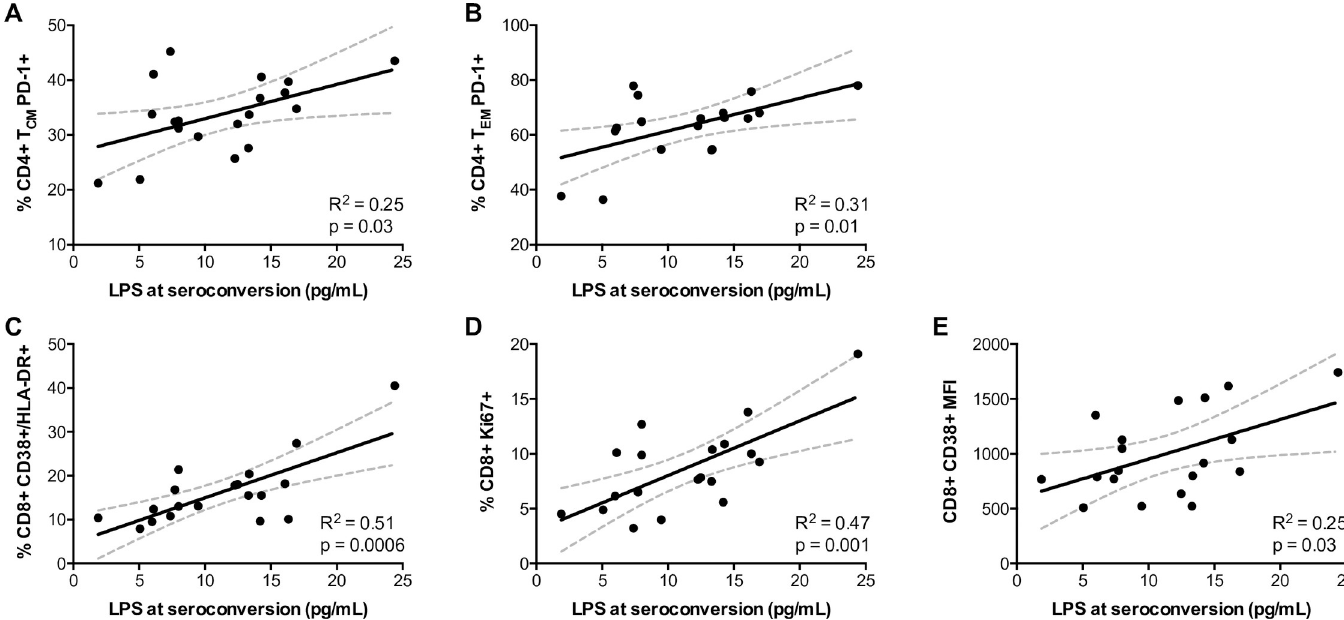
Fig 5. The levels of circulating LPS at seroconversion predict levels of cellular immune activation in the T cell compartment at 3 months post infection. Cryopreserved PBMCs isolated 3 months (mean of 97 days) post infection were stained for markers of immune activation, exhaustion, and cellular turnover as well as for the delineation of memory subsets in CD4 and CD8 T cells for a subset of the cohort for whom cryopreserved PBMCs were available (n = 19). Five of these 19 individuals carried CD4-protective HLA class I alleles. (A–B) Direct associations between LPS levels and the percentage of PD-1+ cells in central memory (CD45RO+/CCR7+) and effector memory (CD45RO+/CCR7-) CD4+ T cells. (C–E) Direct associations between LPS levels and markers of activation (CD38+/HLA-DR+, CD38 MFI) and turnover (Ki67+) in CD8+ T cells. Correlation statistics were generated using linear regression. Solid lines indicate trend lines and dashed lines represent 95% confidence